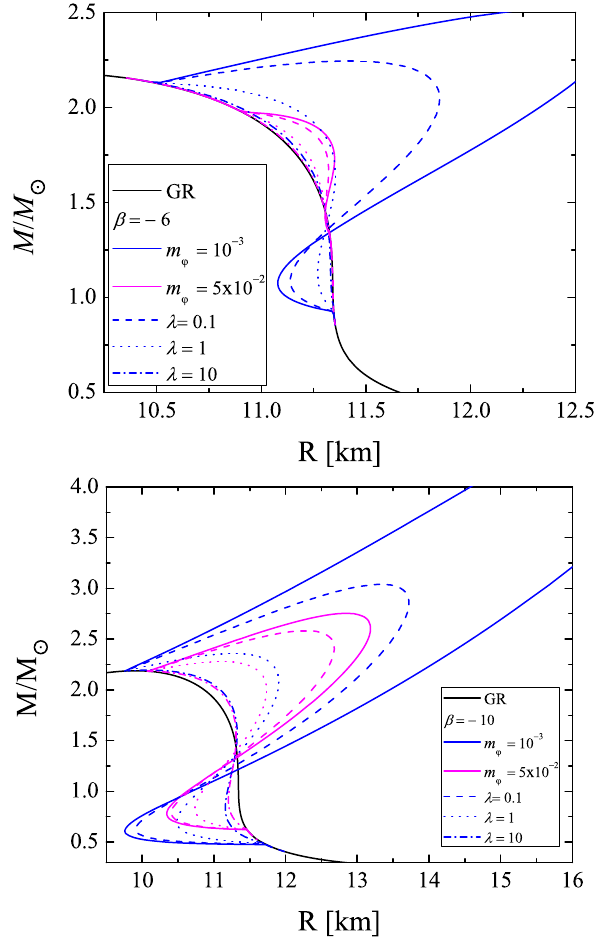
Fig. 1 Mass of radius relation for models with EOS APR4, β = − 6 (top), and β = − 10 (bottom). On both figures are presented results for GR (black continuous line), mass of the scalar field m ϕ = 10 − 3 with λ = 0 (blue continuous line) and m ϕ = 10 − 3 with different values for λ (blue lines in different patterns), and with mass of the scalar field m ϕ = 5 × 10 − 2 with λ = 0(purplecontinuousline)and m ϕ = 5 × 10 − 2 with different values for λ (purple lines in different